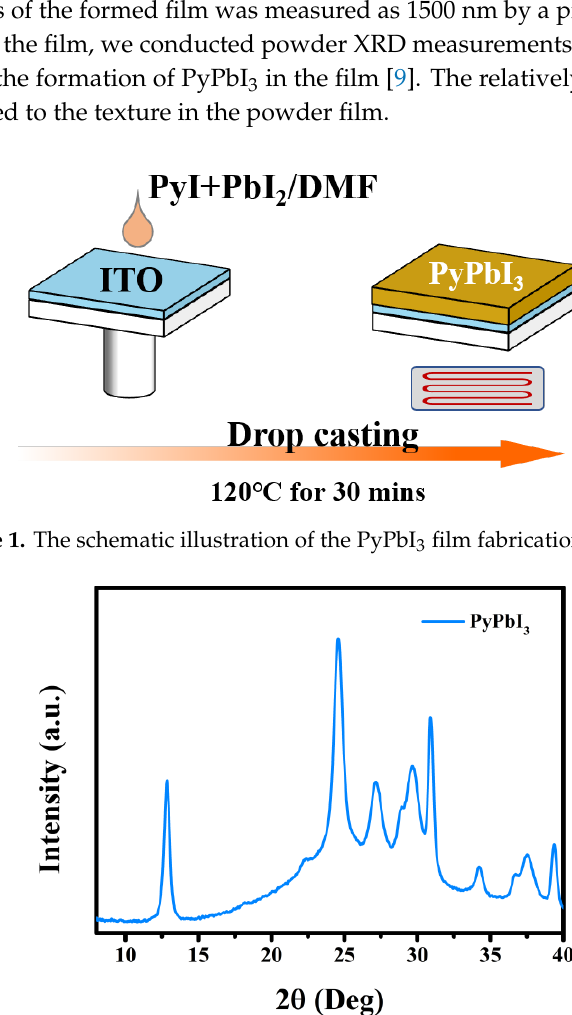
Figure 2. XRD results of the fabricated PyPbI 3 film.